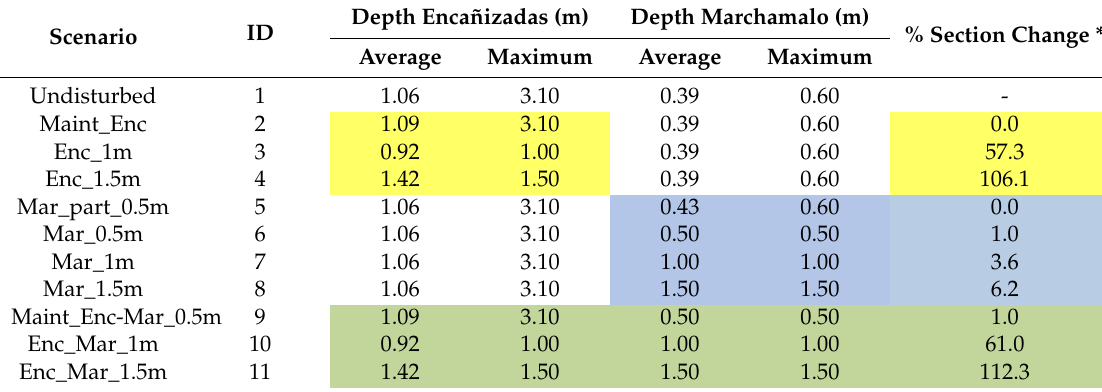
Table 3. Average and maximum depths at the channels for each dredging scenario (yellow: individual dredging at Encañizadas/blue: individual dredging at Marchamalo/green: combined dredging at both channels).